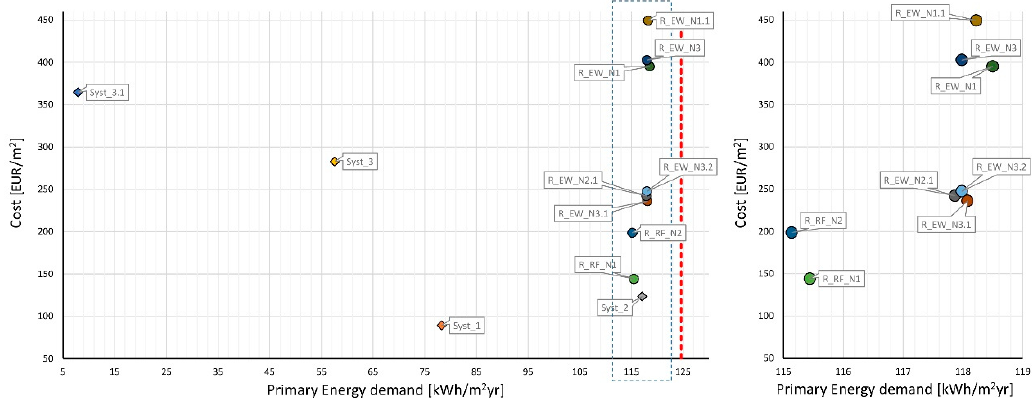
Figure 9. Cost-optimality method results for financial scenario for the single redevelopment measures and discount factor equal to 4% for Rodari school. The red line in the graph shows the primary energy consumption for existing building. On the right the enlargement of the first graph with the retrofitting measures for the external envelope is shown.